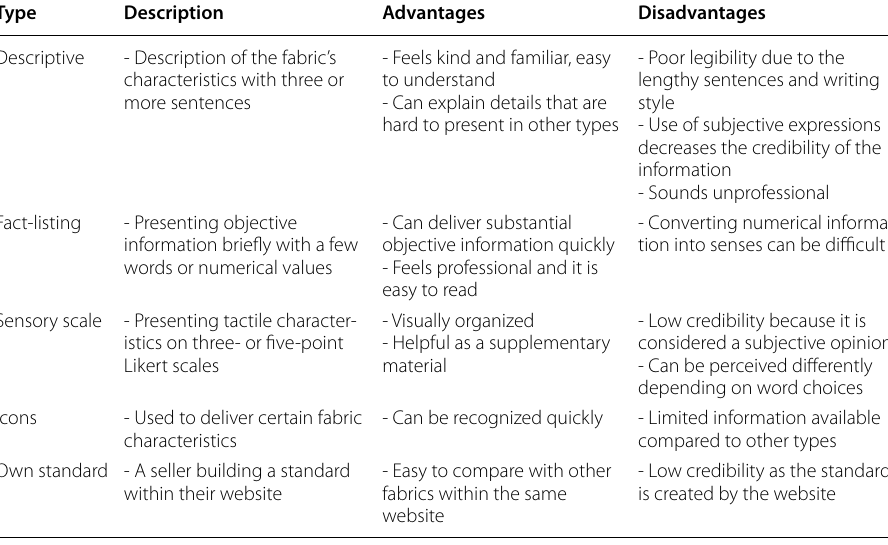
Table 4 Types of textual information and overall perspectives of participants (the preferred methods are highlighted in